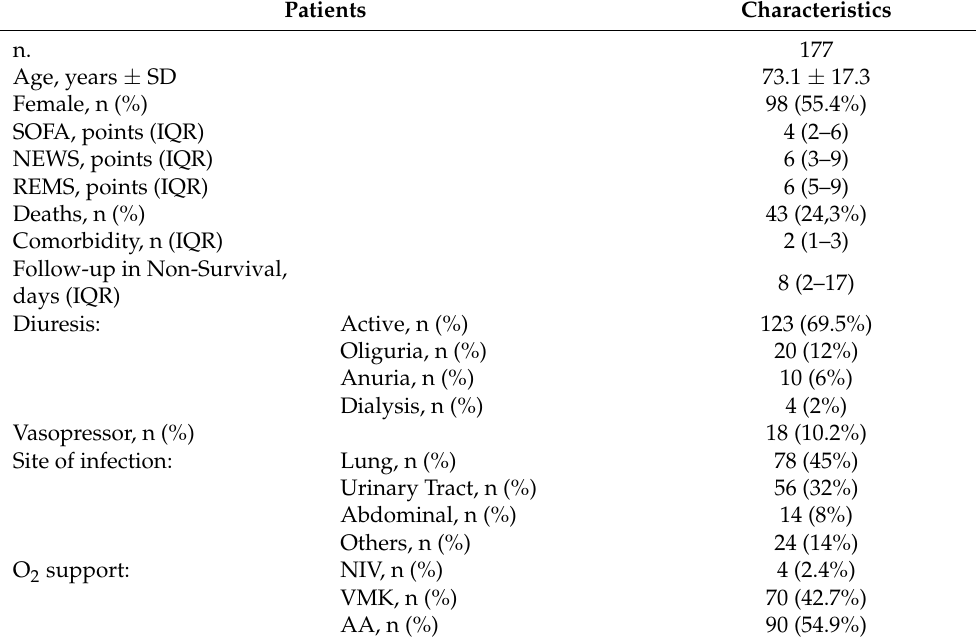
Table 1. Patients